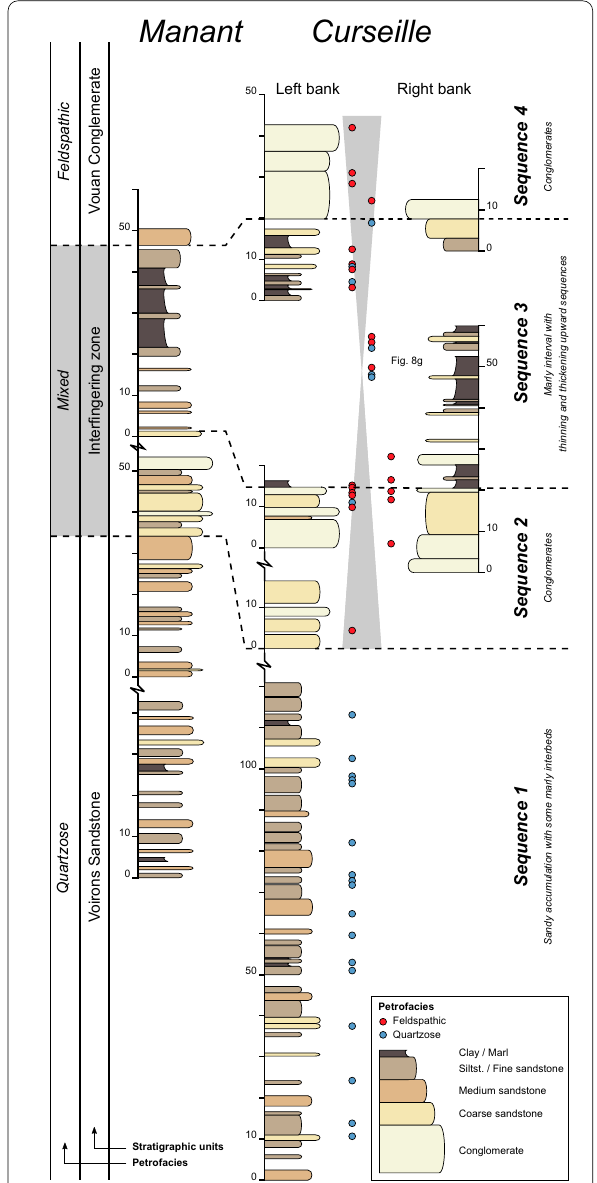
Fig. 11 Interfingered contact between the Voirons Sandstone and the Vouan Conglomerate at the Nant de Manant and Ruisseau de Curseille. This evolution is emphasised by the alternation of the Quartzose petrofacies and the Feldspathic petrofacies. The interfingering zone consists in a mixed alternation of both petrofacies. Note also the simultaneous evolution in the stratigraphy (sequences 1 to